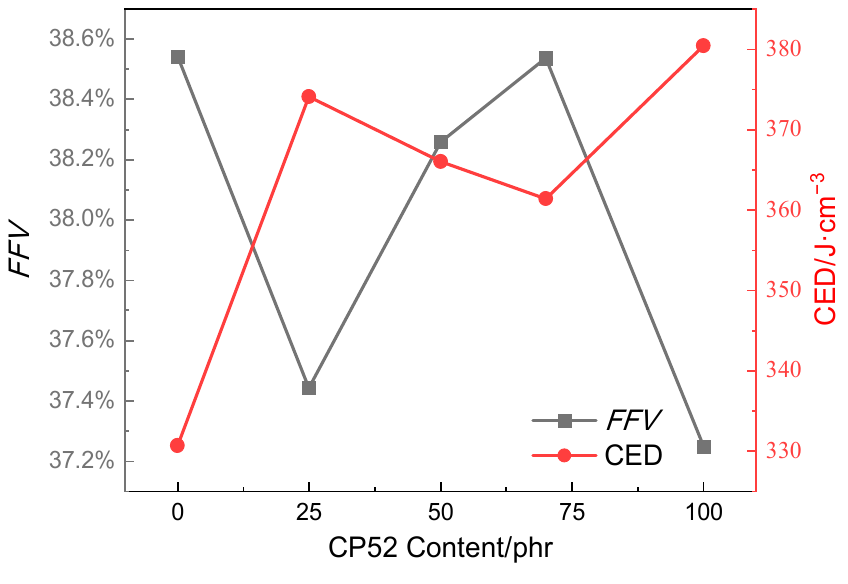
Figure 9. FFV and CED of CP52/NBR